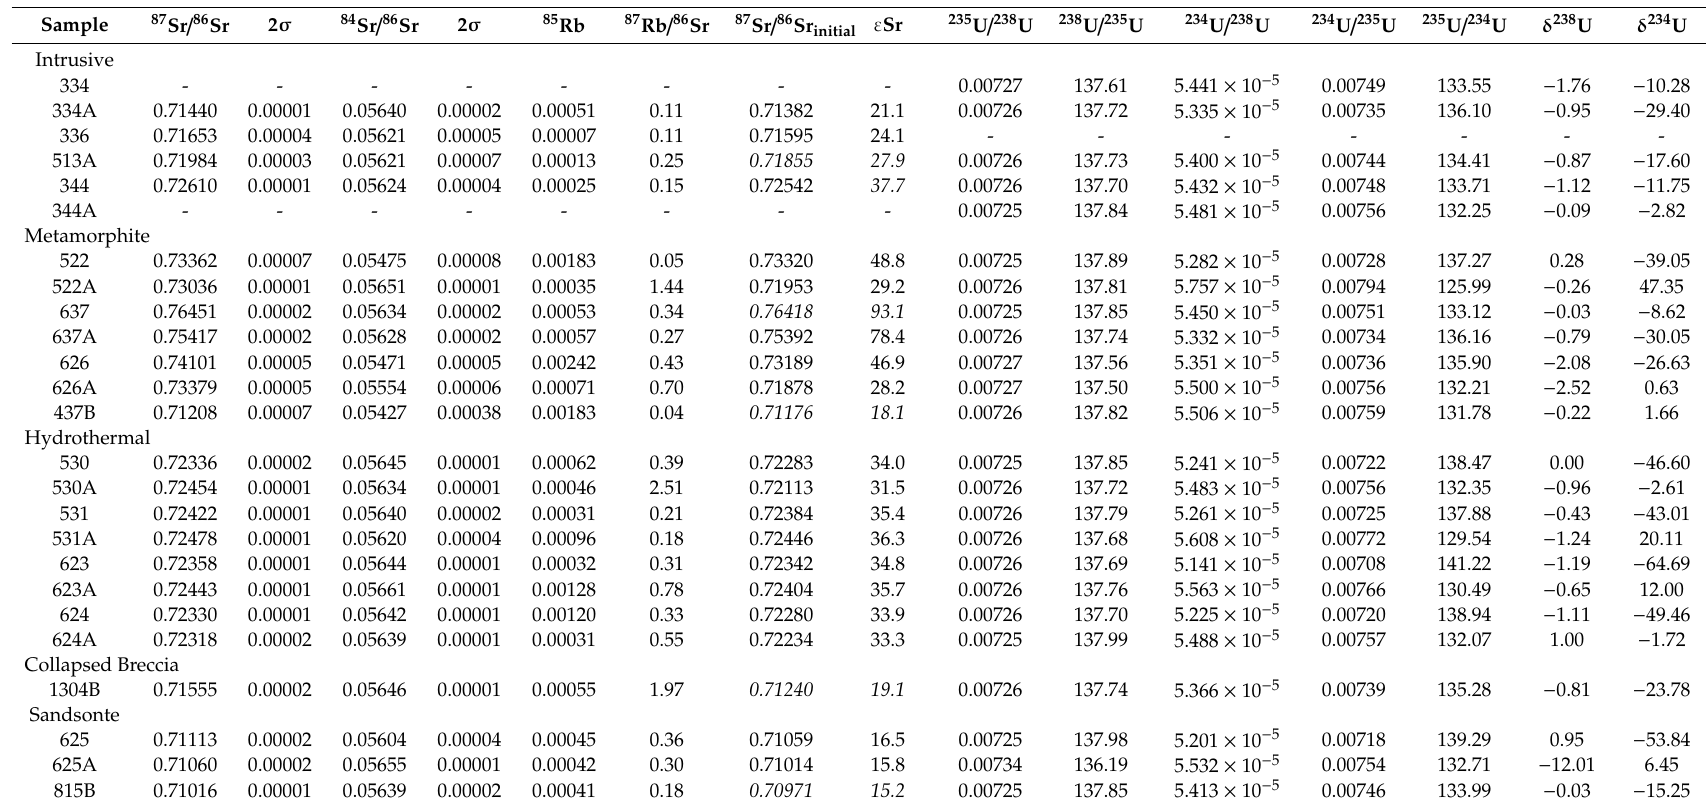
Table 5. Sr and U isotopic compositions obtained by